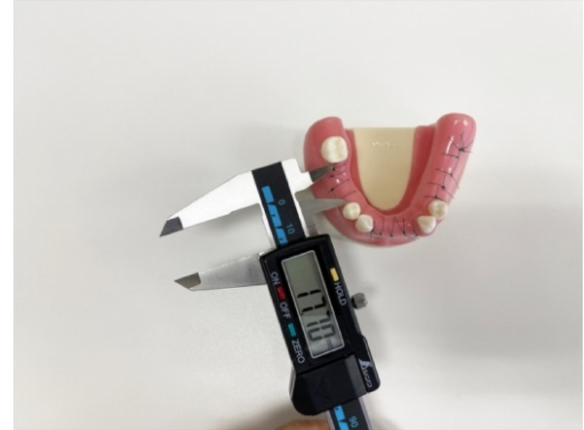
Figure 16. Measurement in the depth direction.